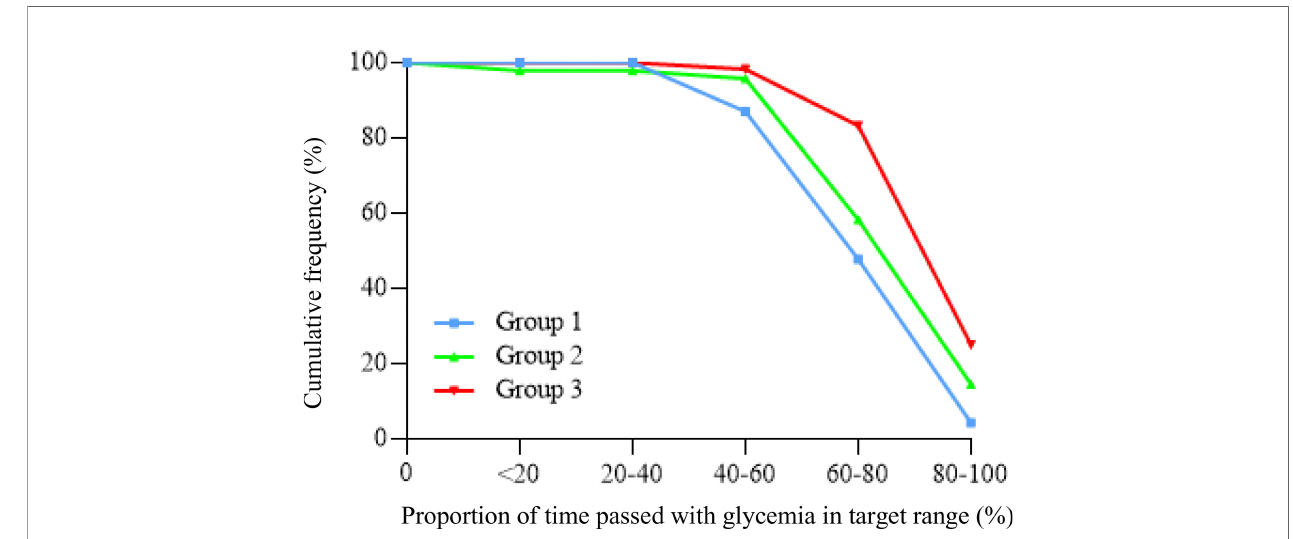
FIGURE 2 | Cumulative frequency of patients reaching target time in range values (>70%) among the three groups of